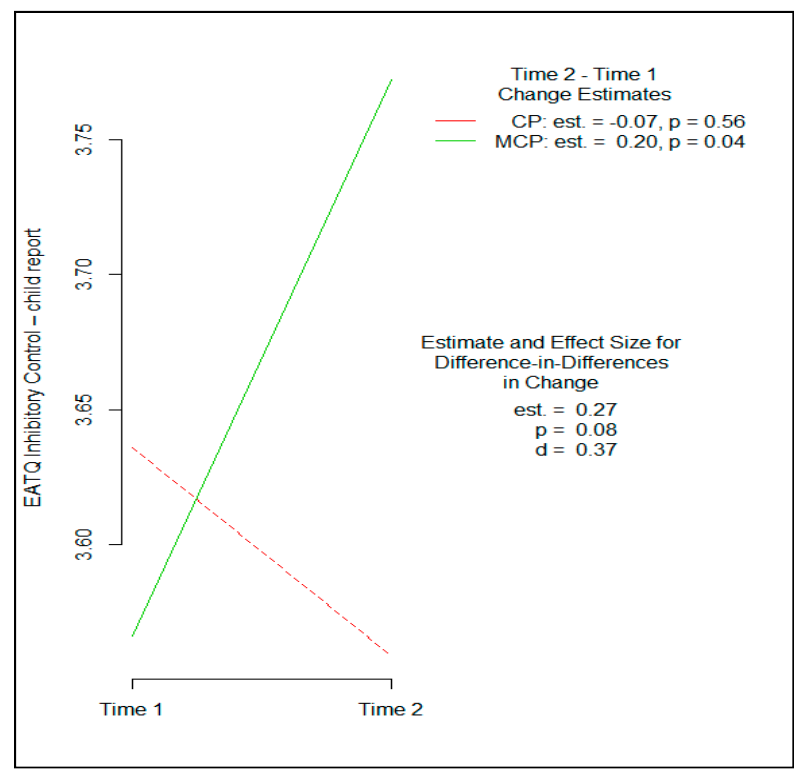
Figure 2. Comparative effects of Coping Power and Mindful Coping Power on children’s inhibitory control on the Early Adolescent Temperament Questionnaire.